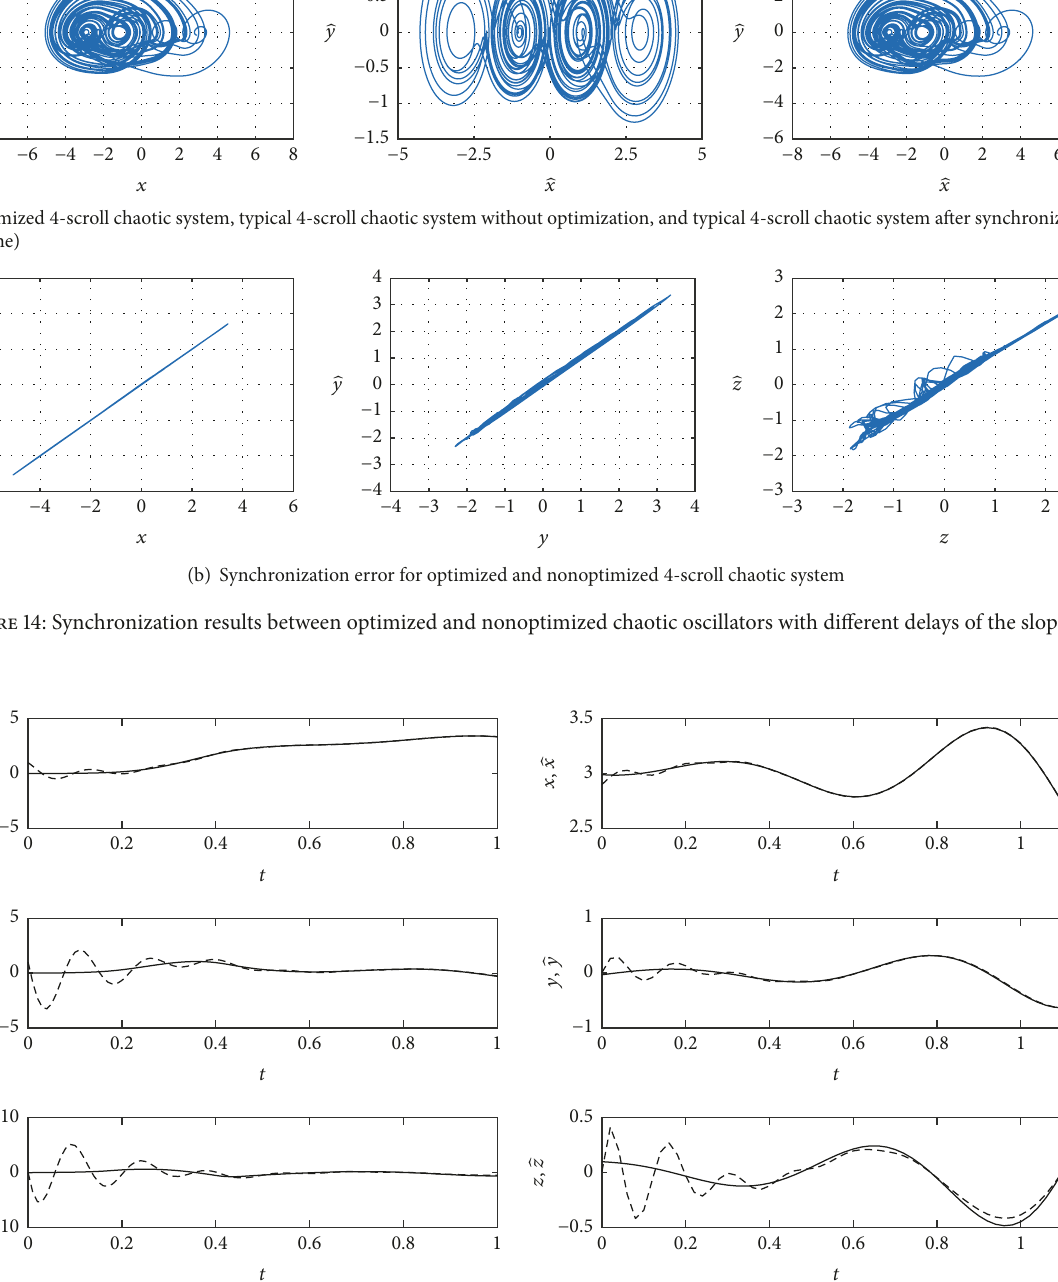
Figure 15: Transient response for both cases in Figures 13 and 14,